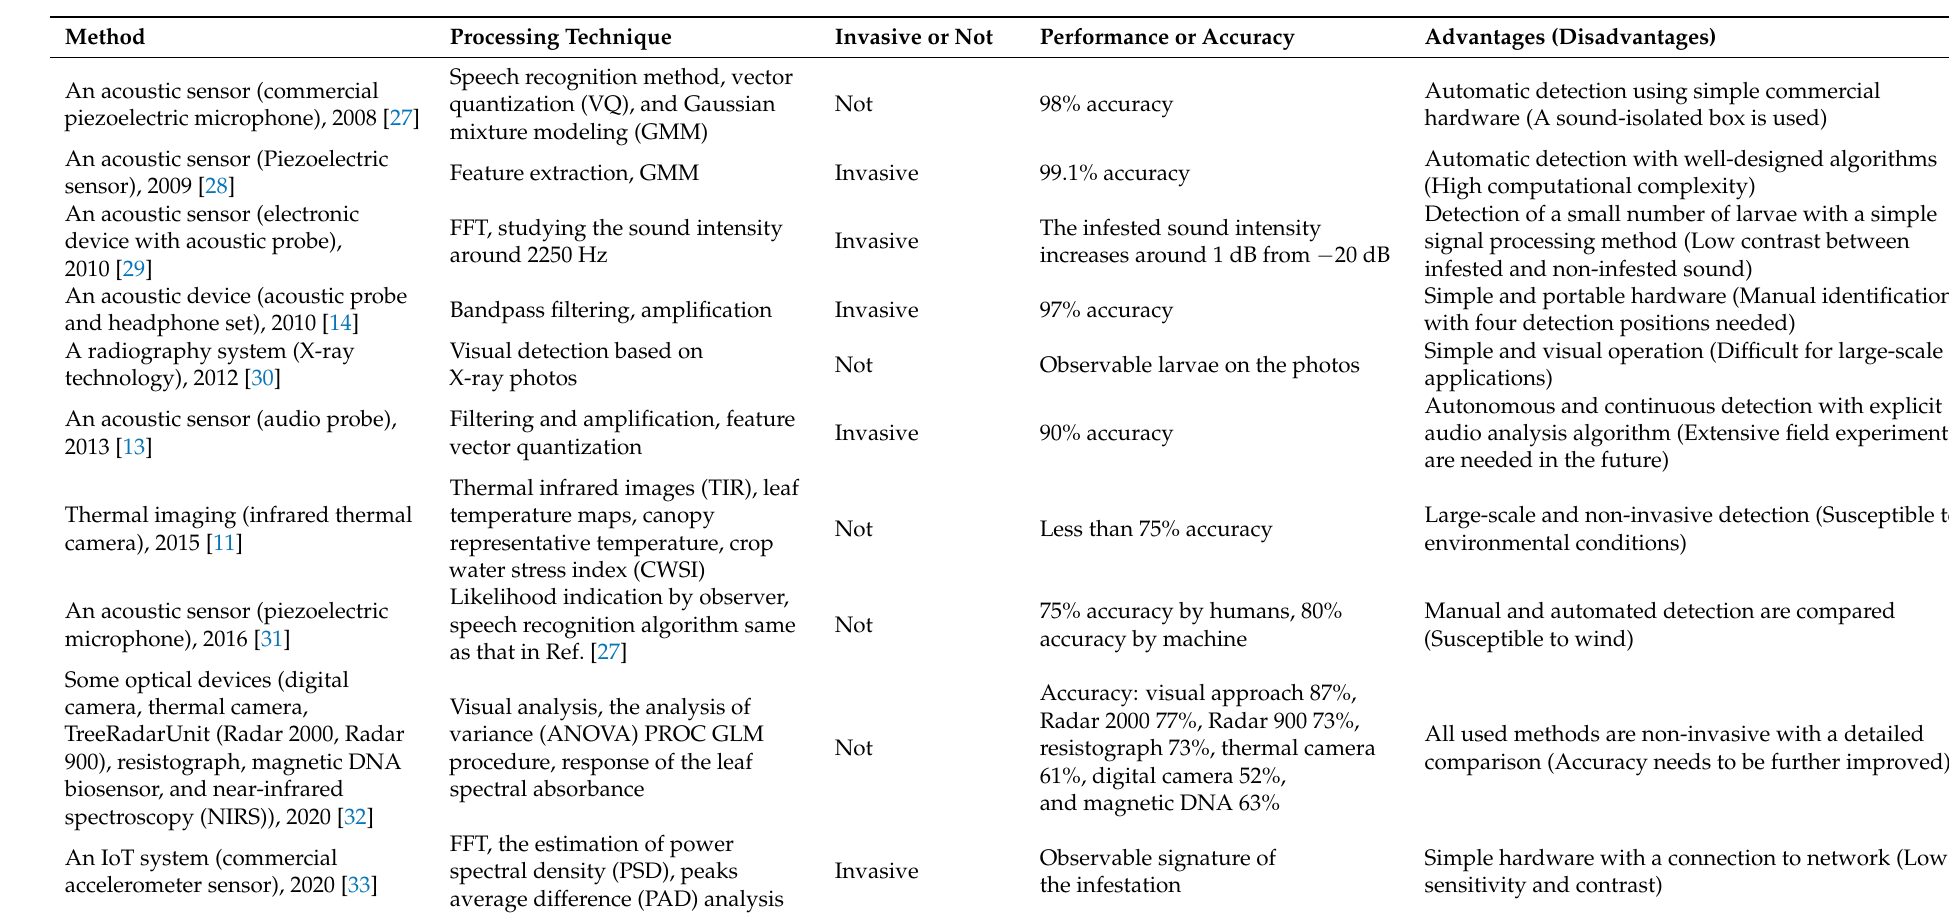
Table 1. Comparison of our DAS+CNN method with existing sensors for RPW detection, in chronological